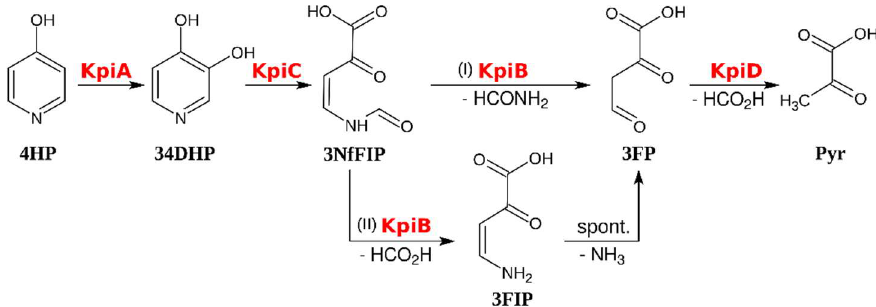
Figure 5. Proposed catabolic pathway of 4HP in Arthrobacter sp. IN13. 4-Hydroxypyridine (4HP), 3,4-dihydroxypyridine (34DHP), 3-( N -formyl)-formiminopyruvate (3NfIP), 3-formiminopyruvate (3FIP), 3-formylpyruvate (3FP), pyruvate (Pyr).